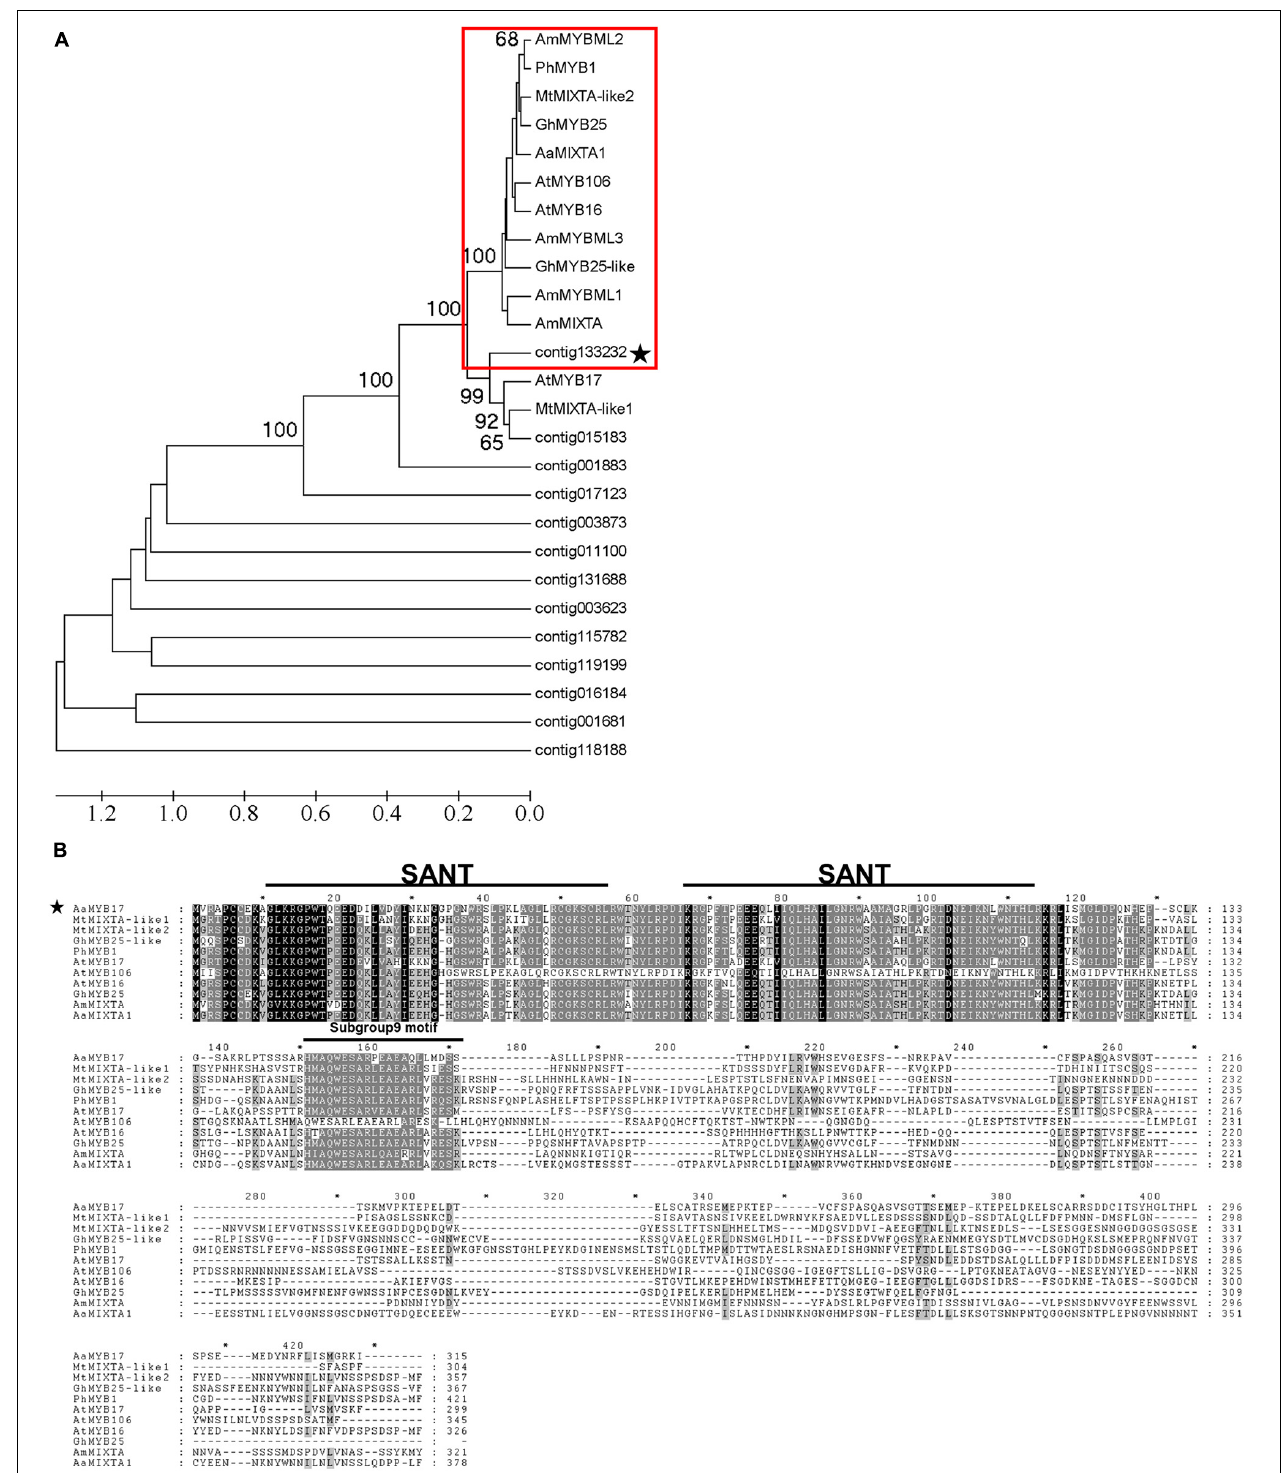
FIGURE 1 | Identification and characterization of AaMYB17 . (A) Phylogenetic tree of MYB proteins expressed in young leaf trichomes, flower bud trichomes, and shoots of A. annua, and some MYBs involved in organ development and cell differentiation from other species. The subgroup 9 MYBs described previously are highlighted in red, and the candidate contig is starred. Sequences were downloaded from the TAIR and NCBI databases. (B) Amino acid sequence alignment of AaMYB17 and MIXTA/MIXTA-like proteins from other species were performed with Genedoc (Nicholas, 1997). The conserved MYB domain and subgroup 9 motif are represented by a line above the sequence. The candidate is